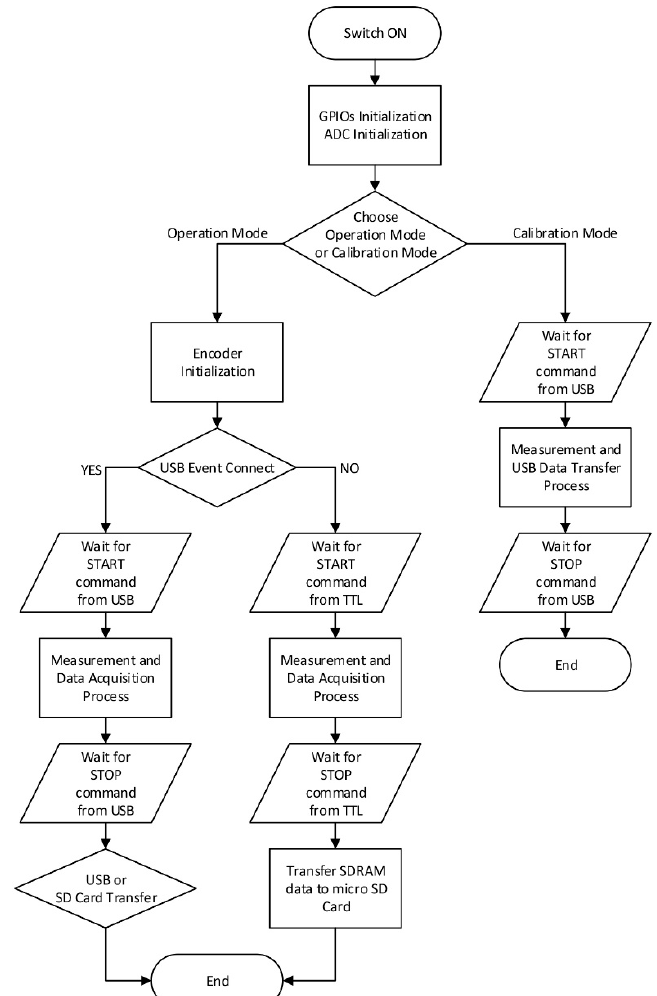
Figure 7. Flowchart of the instrument operation in both “Operation Mode” and “Calibration Mode”.